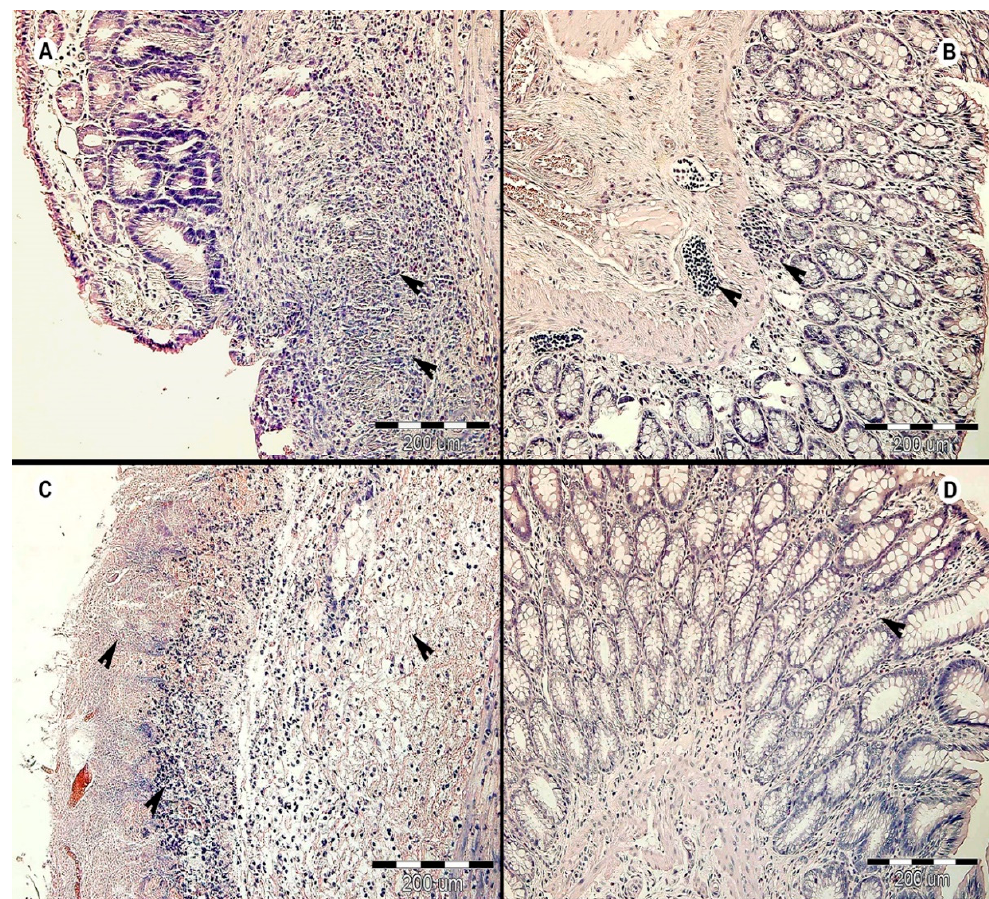
Figure 3. Histopathological examination of the large intestine of rats on Day 31 of the experiment. The representative cross sections are displayed from each experimental group: ( A ) AC group (i.e., antibiotic- and colitis-treated), black arrows indicate inflammatory infiltrate in mucosa and submucosa within necrotic tissue; ( B ) HA group (i.e., colonized and antibiotic-treated), black arrows indicate focal inflammatory infiltrate; ( C ) HC group (i.e., colonized and colitis-treated), black arrows—upper left indicates necrosis of mucosal layer, lower left indicates lymphoplasmacytic inflammatory infiltrate, and right indicates submucosal edema; ( D ) HAC group (i.e., colonized, antibiotic-, and colitis-treated), black arrow indicates inflammatory infiltrate.